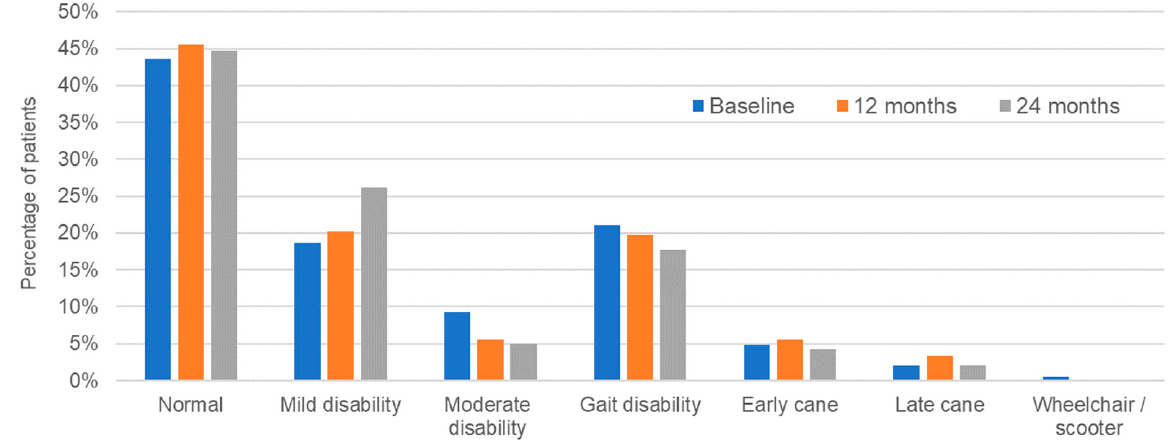
Figure 3. Percentages of patients at each PDDS level from baseline to 2 years.